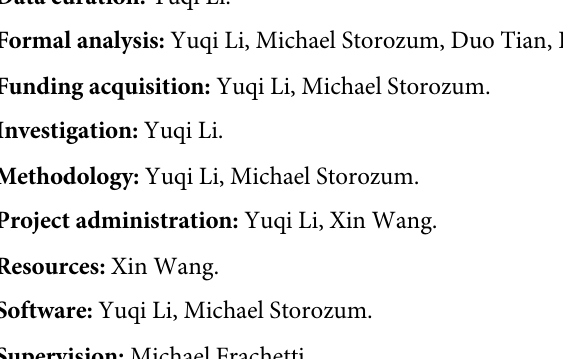
S1 Table. Macrobotanical remains identified from the flotation samples of MGK4. S2 Table. Results of geoarchaeological analysis (except for geochemical analysis). S3 Table. Results of geochemical analysis. S1 Fig. Oxcal plot of radiocarbon